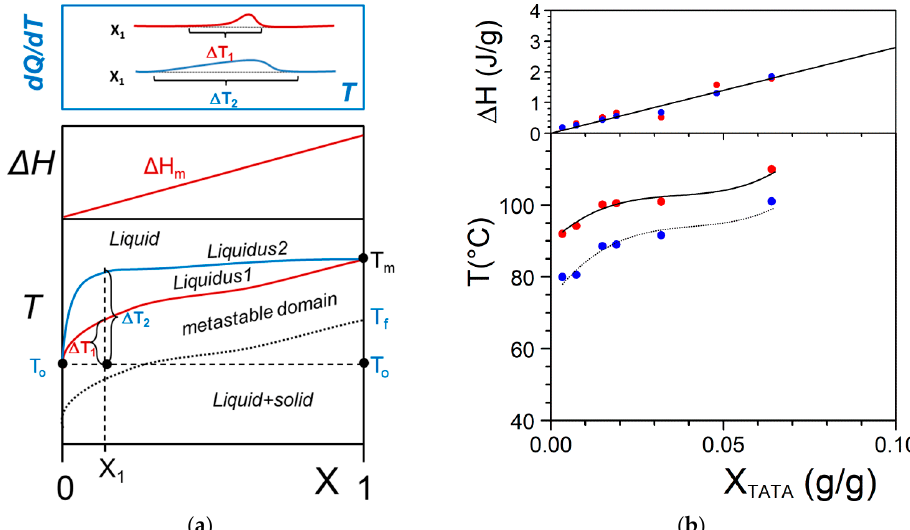
Figure 4. ( a ) The simplest T-X phase diagram for a two-component system. Two liquidus lines are considered with two different Δ T at a given [ X 1 , T o ] coordinate. The dotted black line stands for the gel formation. T m and T f are the melting and the formation temperatures of the pure gelator. Top, Tamman’s diagram. Above: shape of the expected endotherms; ( b ) experimental T-C phase diagram for Tri-aryl triamine/bromobenzene organogels (chemical structure in Appendix A Figure A2) [27,28]; ( • ) = melting, ( • ) = formation. Note the low composition range for the gelator. The proportion of the different phases is given by the lever rule. For example the fraction ϕ of the different phases read at a temperature T :